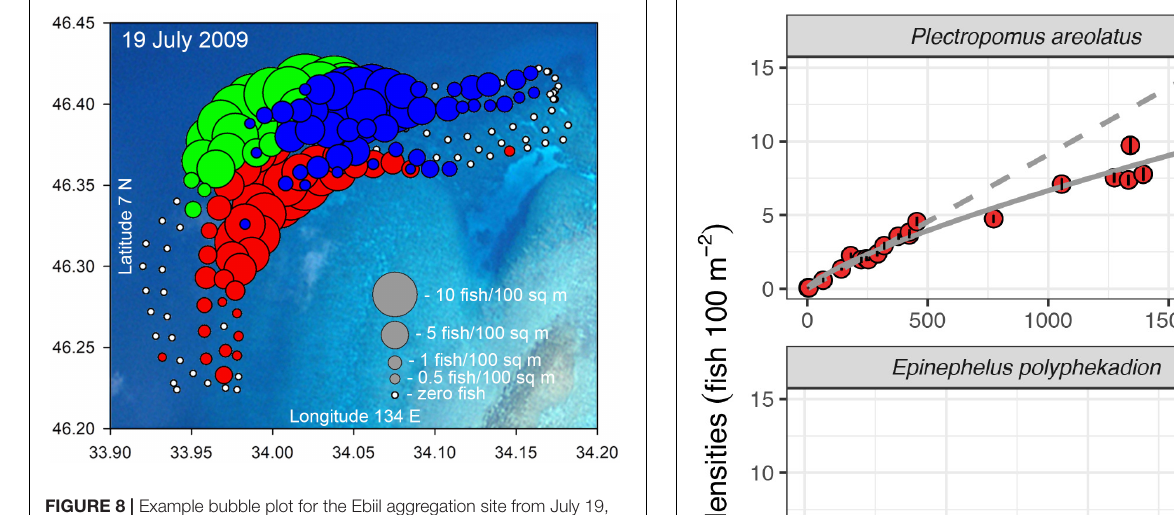
FIGURE 8 | Example bubble plot for the Ebiil aggregation site from July 19, 2009 indicating density (fish/100 m 2 ) counted along five transects for P. areolatus (red), E. polyphekadion (green), and E. fuscoguttatus (blue). This was a day of high abundance with (respectively) 324, 537, and 424 individuals counted. Some bubbles for E. polyphekadion and P. areolatus are masked by overlying blue bubbles of E. fuscoguttatus . Small white dots indicated no fish at that location. Variations in transects from design ( Figure 1 ) were due to surveyors or their towed GPS drifting slightly off track, as evidenced by GPS position logging.